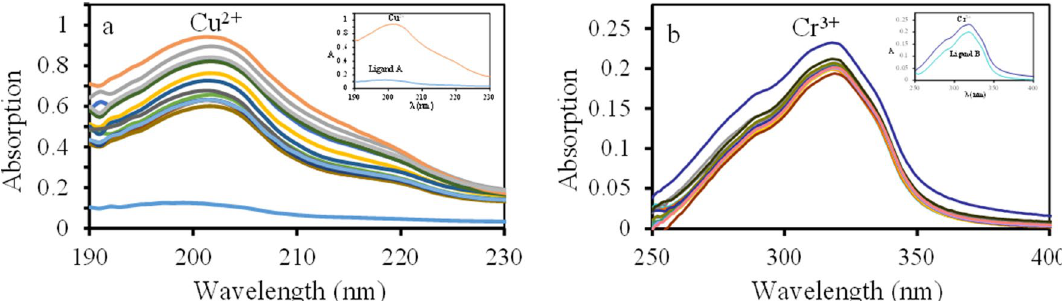
Figure 1. The UV–visible spectrum changes of 1.0 × 10 –5 M ( a ) ligand A and ( b ) ligand B solution, after addition of 300 µL of 1 mM solutions containing one of the Cr 3+ , Cu 2+ , Ca 2+ , Co 2+ , Mg 2+ , Fe 2+ , Zn 2+ , Ag + , Mn 2+ , Hg 2+ , Cd 2+ , Ni 2+ and Pb 2+